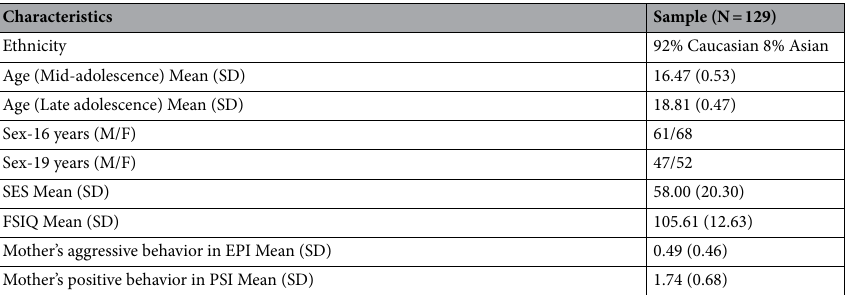
2.26, SD 0.53) and 75 participants in late adolescence (mother’s aggressive behavior in EPI: M 0.75, SD 0.43; mother’s positive behavior in PSI: M 2.26, SD 0.48; Table 1). There was no difference between this sample and the